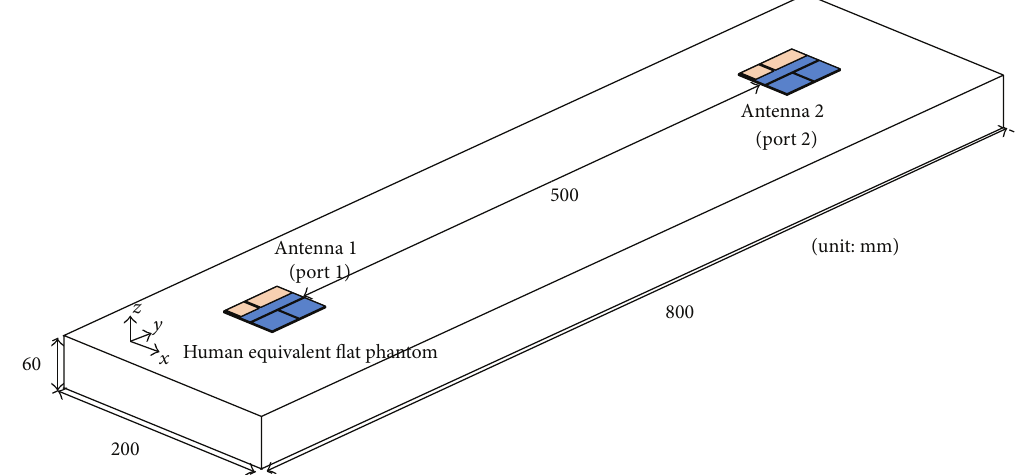
Figure 15: Simulation set-up of the on-body to on-body communication link.